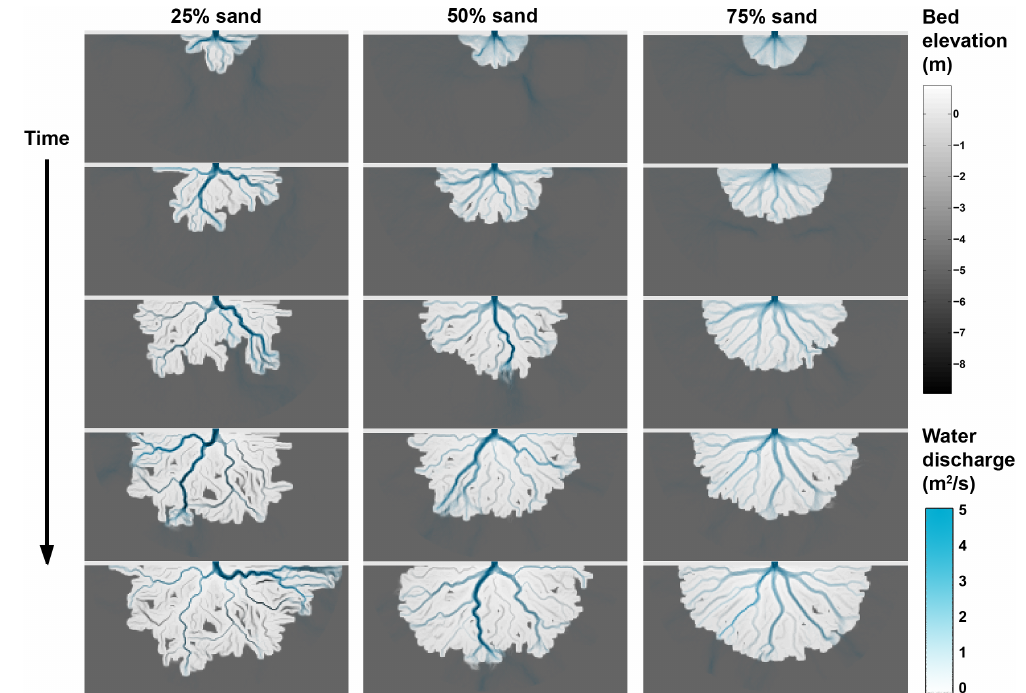
Figure 6. Time series of delta formation with different ratios of sand and mud flux (runs 1, 2 and 3). The time interval between rows is roughly 200 days of delta building time with continuous bank-full discharge.